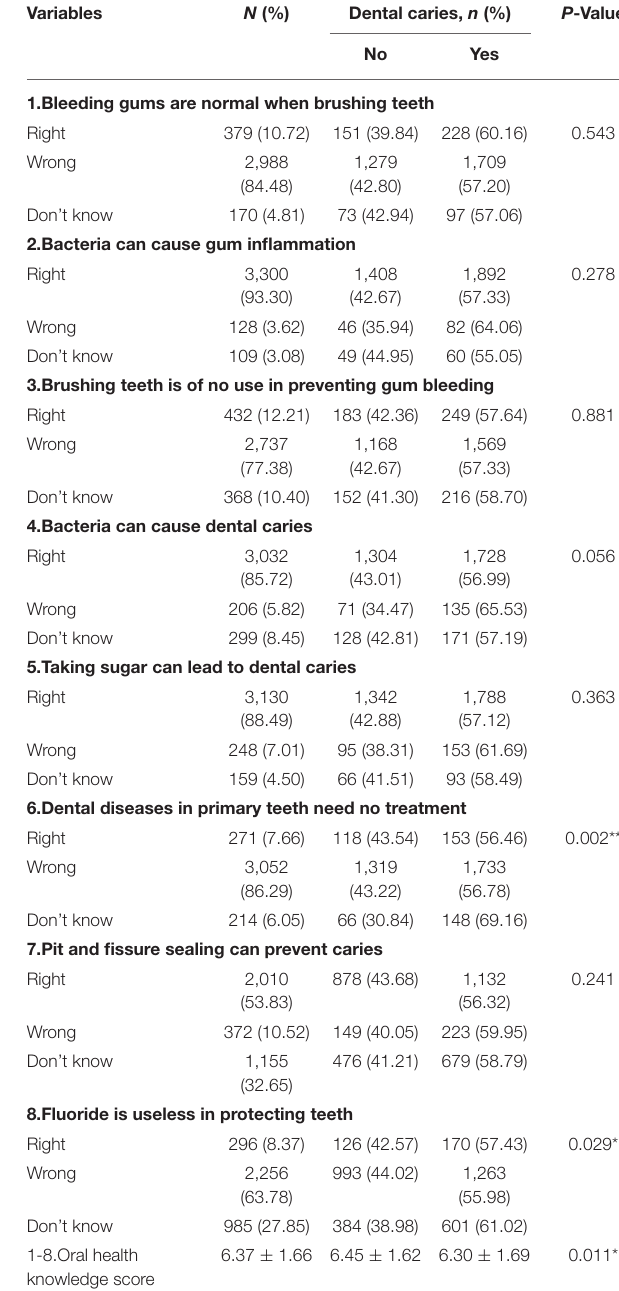
TABLE 2 | Comparison of eating habits and oral health care between 2016 and 2021.